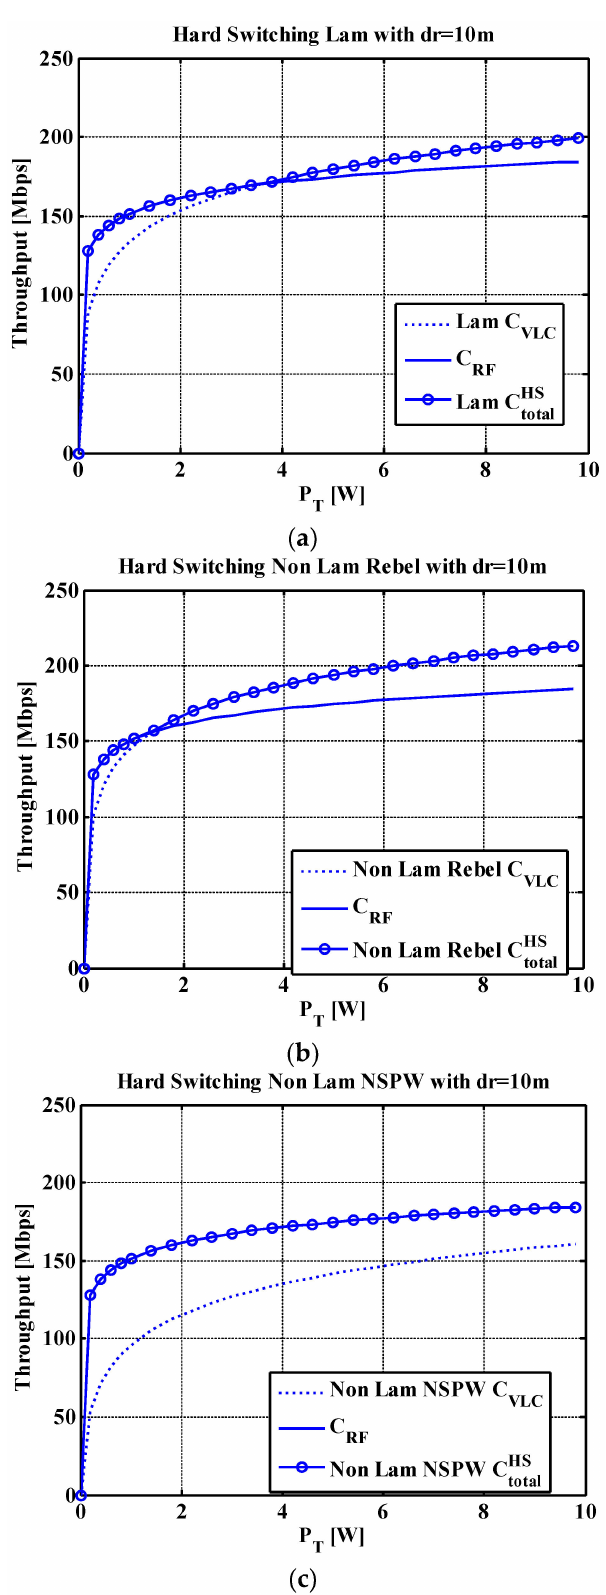
Figure 7. RF, VLC, and total throughput comparison versus total available power for ( a ) Lambertian optical beam configuration, ( b ) LUXEON Rebel optical beam configuration, and ( c ) asymmetric NSPW optical beam